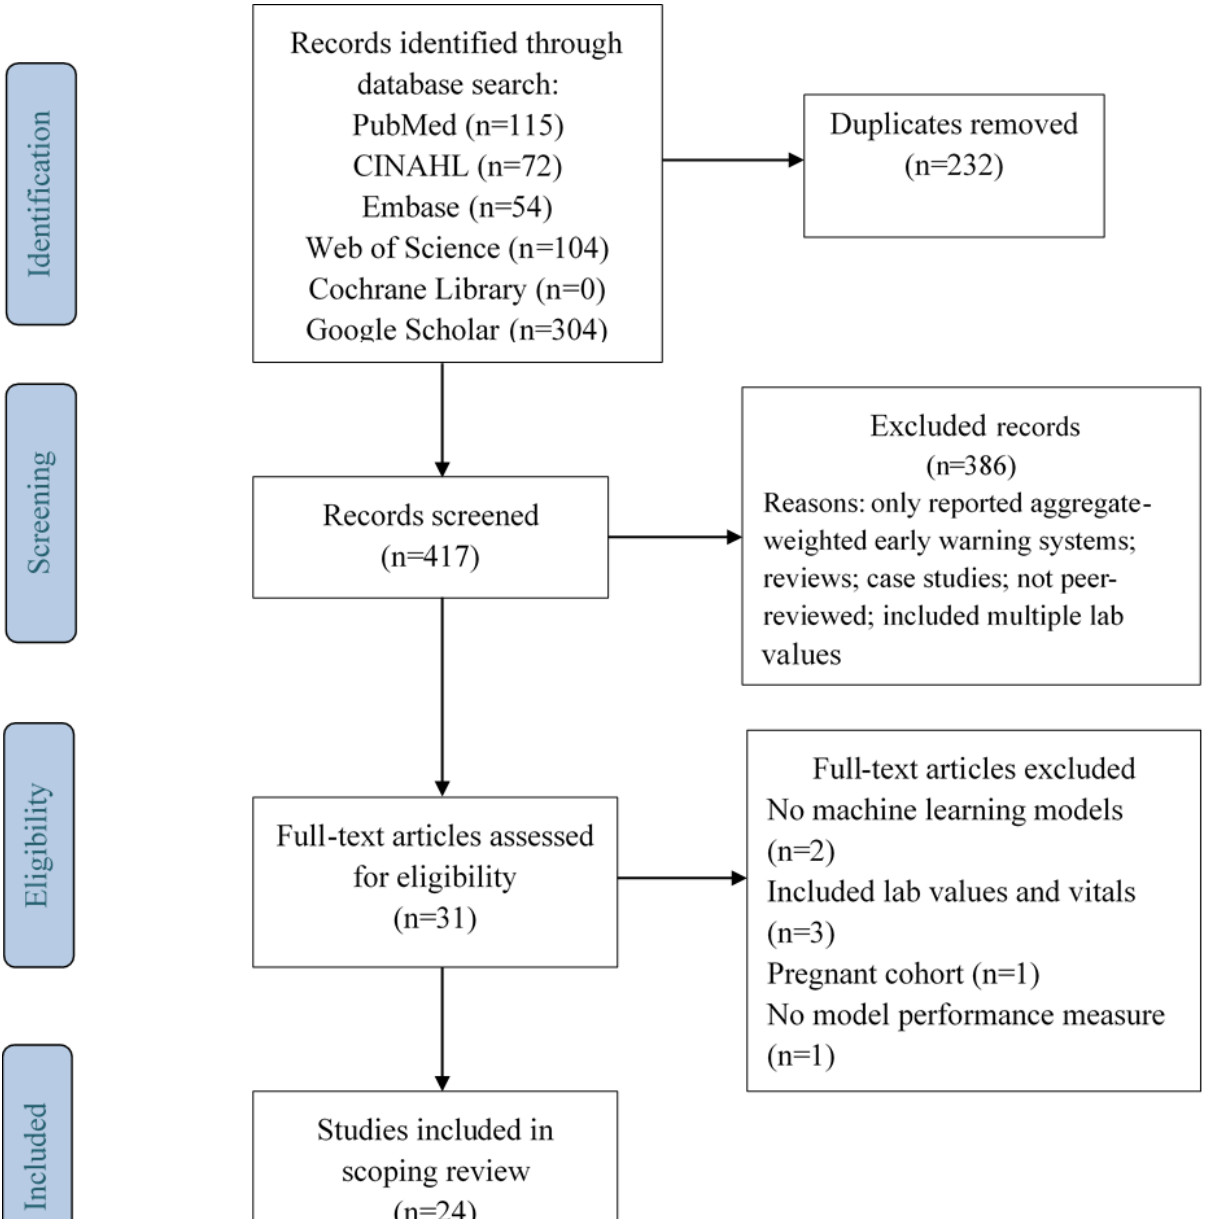
Figure 1. PRISMA flowchart of the search strategy and study